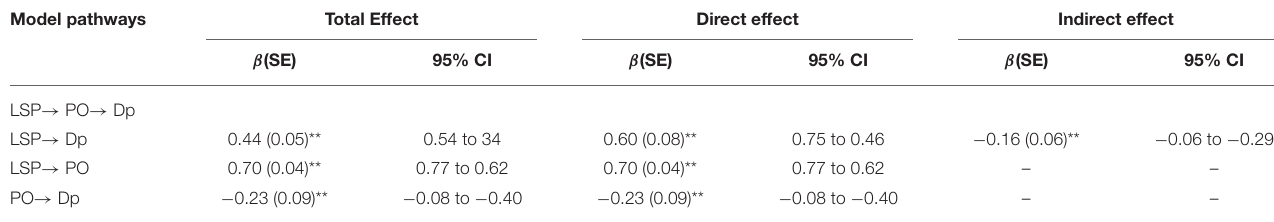
TABLE 3 | Bootstrap analyses of the magnitude and statistical significance of indirect